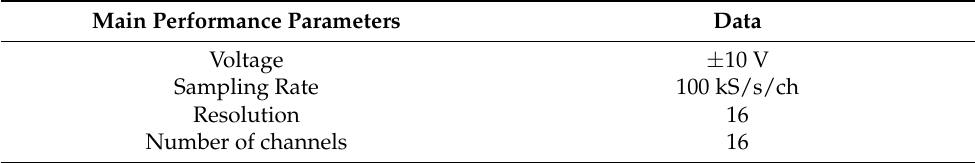
Figure 6. Data acquisition system. ( a ) NI9220 Data Acquisition Card, ( b ) NI CompactDAQ Chassis. Table 4. The main performance parameters of the data collection card. Main Performance Parameters